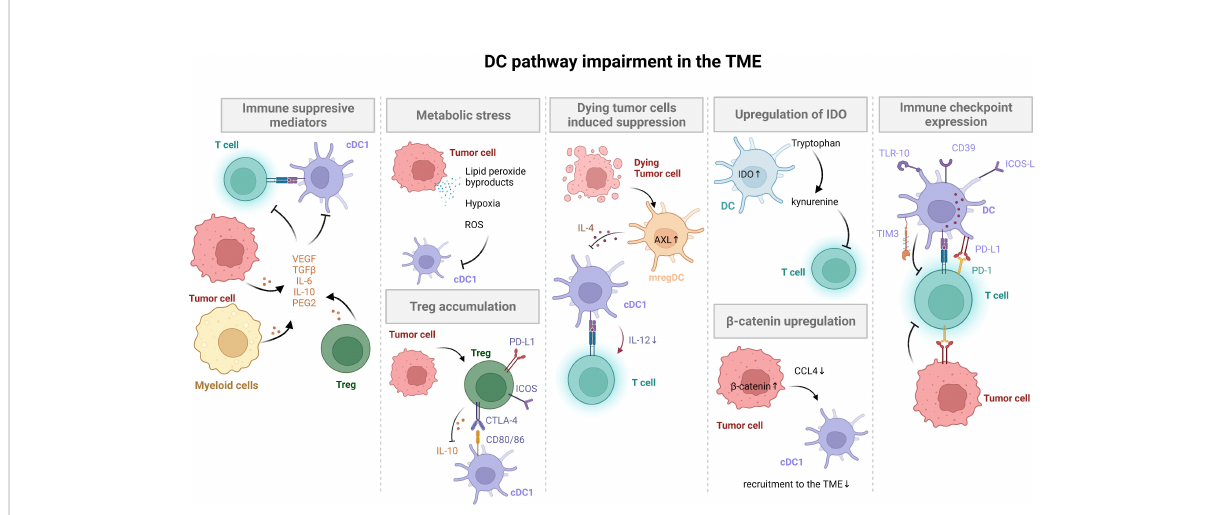
FIGURE 2 DC pathway impairment in the TME. Tumor cells inhibit DC activation and maturation through b -catenin and ROS production, soluble factor secretion (VEGF, TGF b , IL-10, PGE2), and induction of immune checkpoint expression (PD-L1). Tumors with low neoantigen expression do not ef fi ciently prime DCs, avoiding T cell activation. Activation of the mregDC program and additional immune checkpoint expression on DCs (e.g. TIM3) in tumors also limits T cell activation. Finally, immunomodulatory molecules secreted by tumors or expressed by DCs stimulate Treg cells, leading to tumor immune